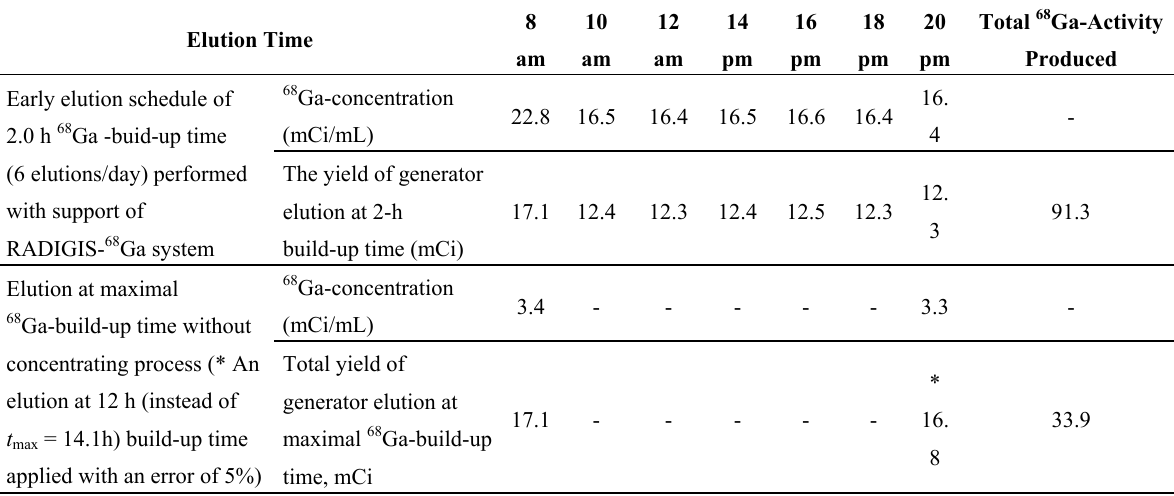
Table 3. Effectiveness of 68 Ga elution performed by the combination of Build-up time optimisation and Early elution schedule method supported by an integrated elution-purification- concentration process (RADIGIS- 68 Ga system) in comparison with that normally eluted at the time point of maximal 99m Tc-build-up. (Generator activity at calibration day (day 1, 8:00 am) is 18.0 mCi 68 Ge or 18.0 mCi 68 Ga; Solvent for generator elution is 5 mL 0.1